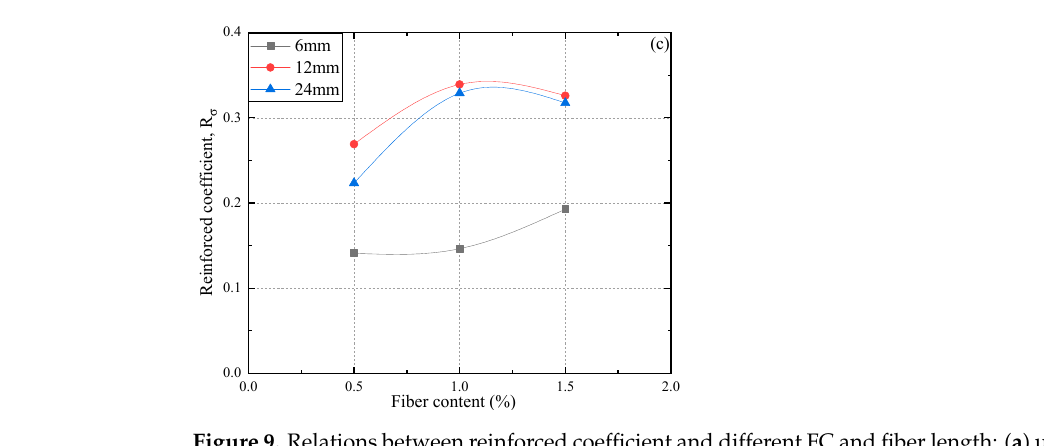
Figure 9. Relations between reinforced coefficient and different FC and fiber length: ( a ) under 200 kPa, ( b ) under 300 kPa, ( c ) under 400 kPa.